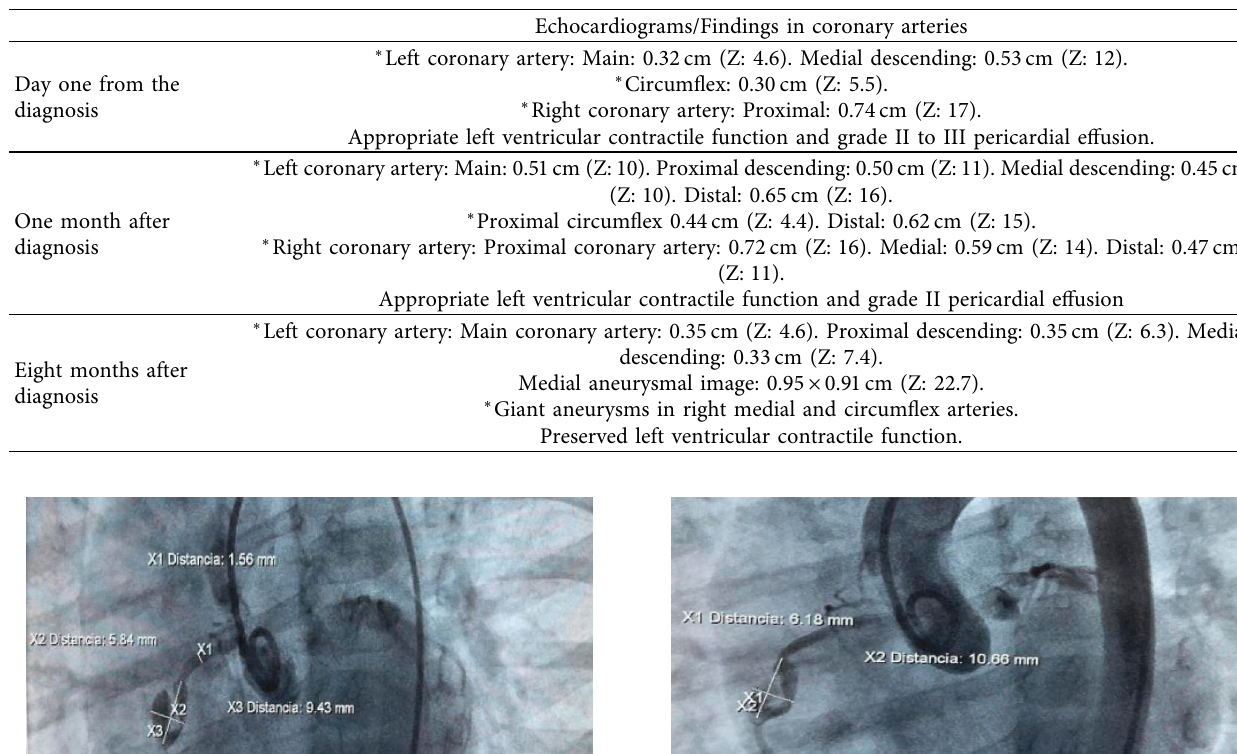
Table 2: Echocardiograms.